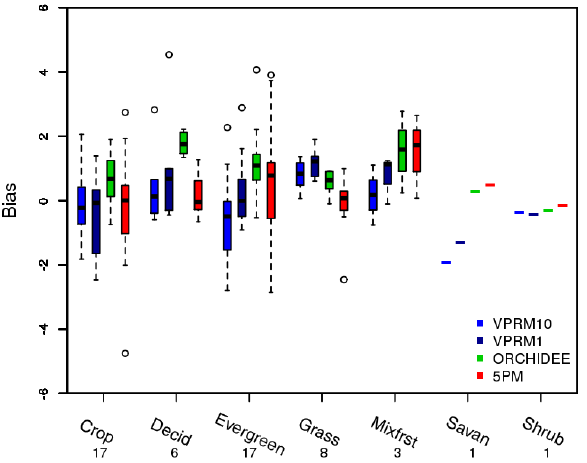
Figure 3. Box and whisker plot for the annual site-specific biases of the models differentiated by vegetation type. Units at y axis are in µmol m − 2 s − 1 (for conversion to gC m − 2 yr − 1 reported values in y axis should be multiplied by 3787694).